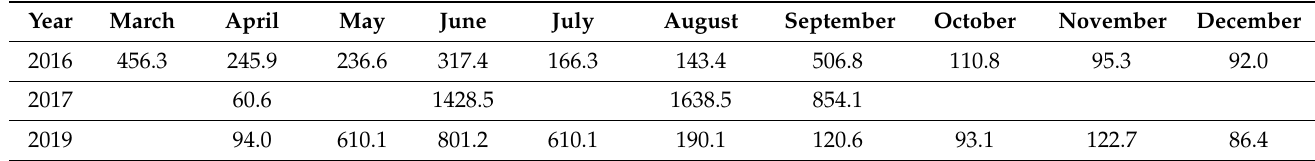
Table 3. Monthly maximum of the total biomass (B, mg m − 3 ) of phytoplankton in 2016, 2017, and 2019.